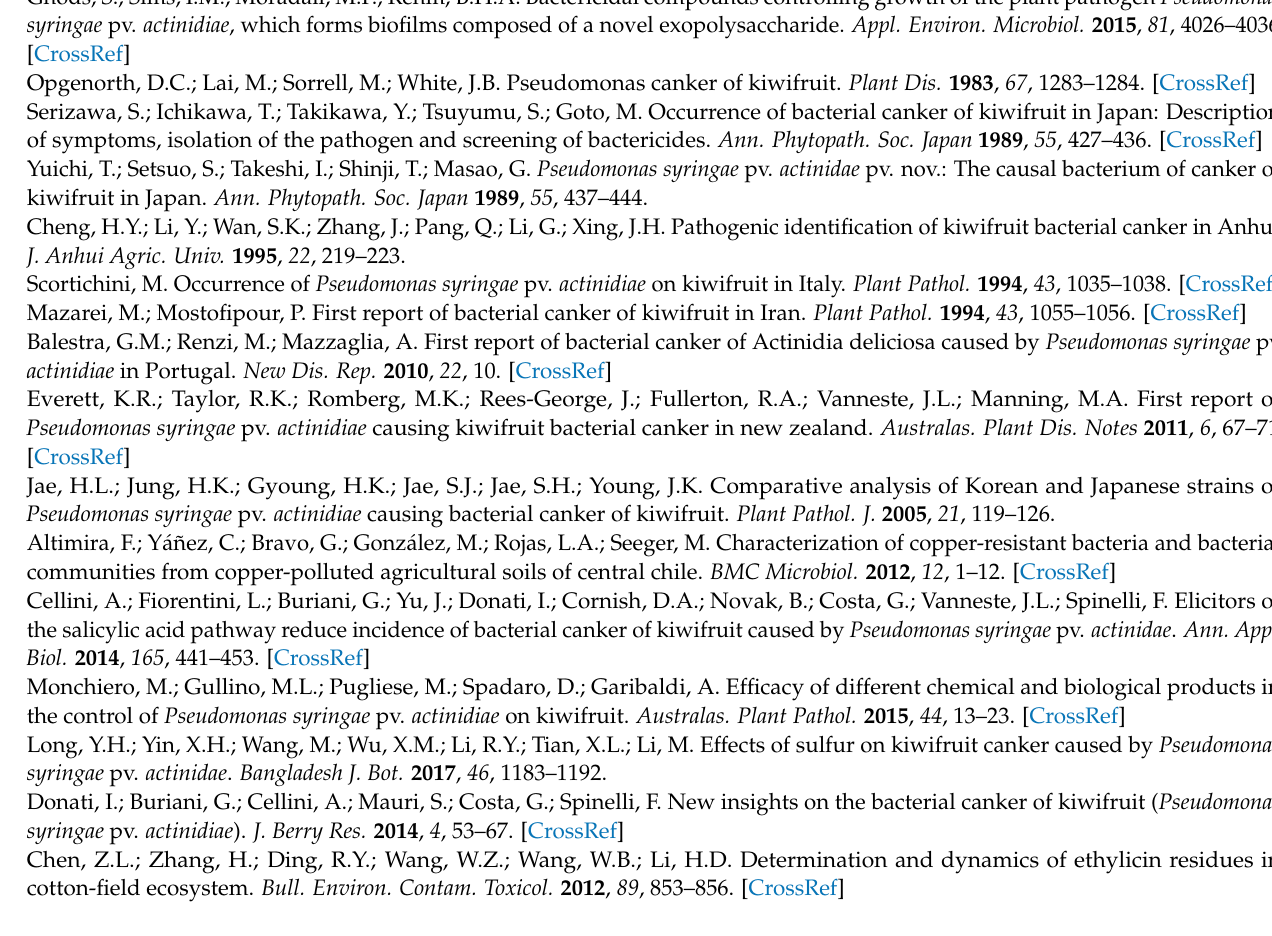
Differential gene clustering line chart, Figure S3: GO enrichment analysis, Figure S4: BP Directed Acyclic Graph, Figure S5: CC Directed Acyclic Graph, Figure S6: MF Directed Acyclic Graph, Figure S7: Statistics of the number of differential genes in the top 10 pathways enriched by KEGG, Figure S8: Flagellar assembly pathway, Figure S9: Biofilm formation– Pseudomonas aeruginosa pathway. Table S1: Primer sequences used for qRT-PCR, Table S2: Data quality statistics and reference sequence matching after filtering, Table S3: The list of different expression genes, Table S4: GO enrichment list of different expression genes, Table S5: KEGG pathway enrichment list of different expression